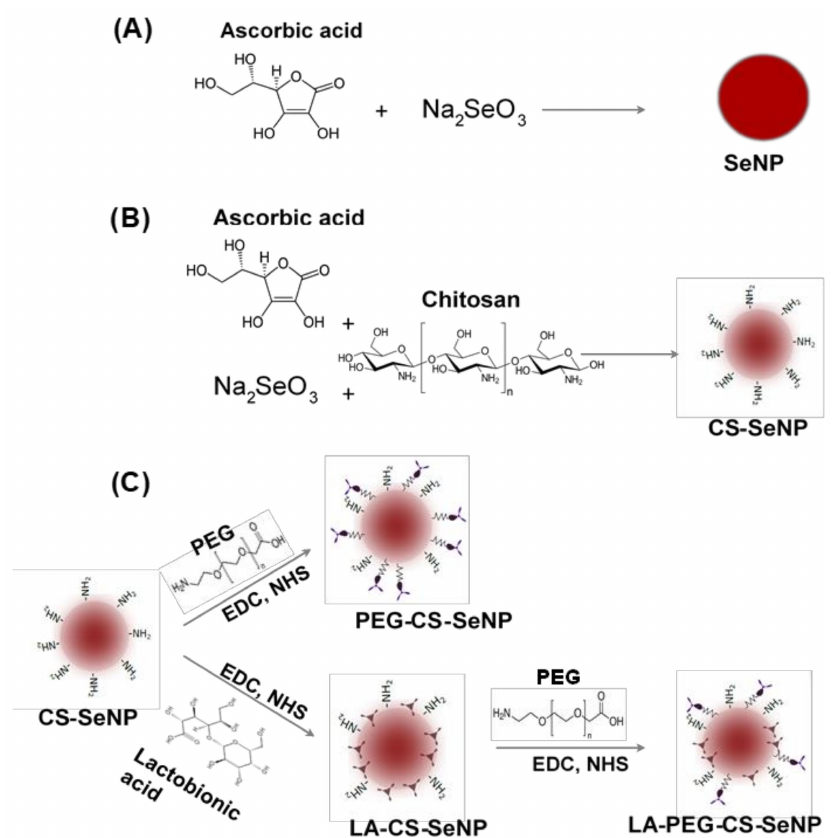
Figure 1. Scheme for the synthesis of ( A ) Selenium nanoparticles (SeNPs), ( B ) chitosan-selenium nanoparticles (CS-SeNPs), and ( C ) lactobionic acid-chitosan-selenium nanoparticles (LA-CS- SeNPs), polyethylene glycol-chitosan-selenium nanoparticles (PEG-CS-SeNPs) and lactobionic acid- polyethylene glycol-chitosan-selenium nanoparticles